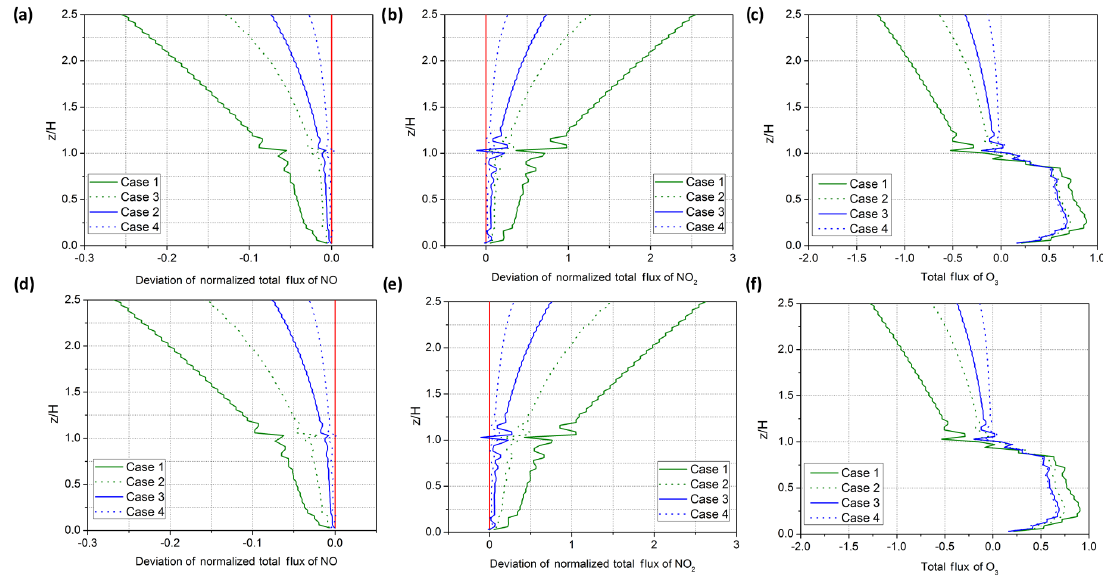
Figure 9. Vertical profiles of the deviation of < w NO > N and < w NO 2 > N from the normalized total flux of tracer and the < w O 3 > N for the (a – c) PSS and (d – f) CCM1/2 in the 3-D geometry for all study cases. The red line is the normalized total flux of the